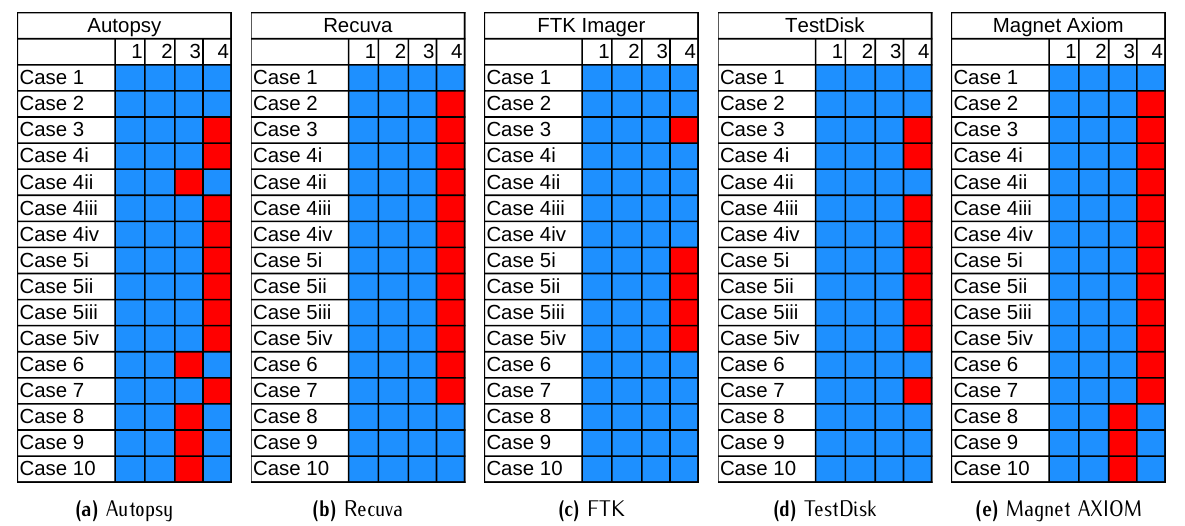
Figure 10. Test results on FAT test cases for each DFR tool. Rows represent test cases whereas columns represent NIST core features. Blue is passing, red is failing, gray is not tested.